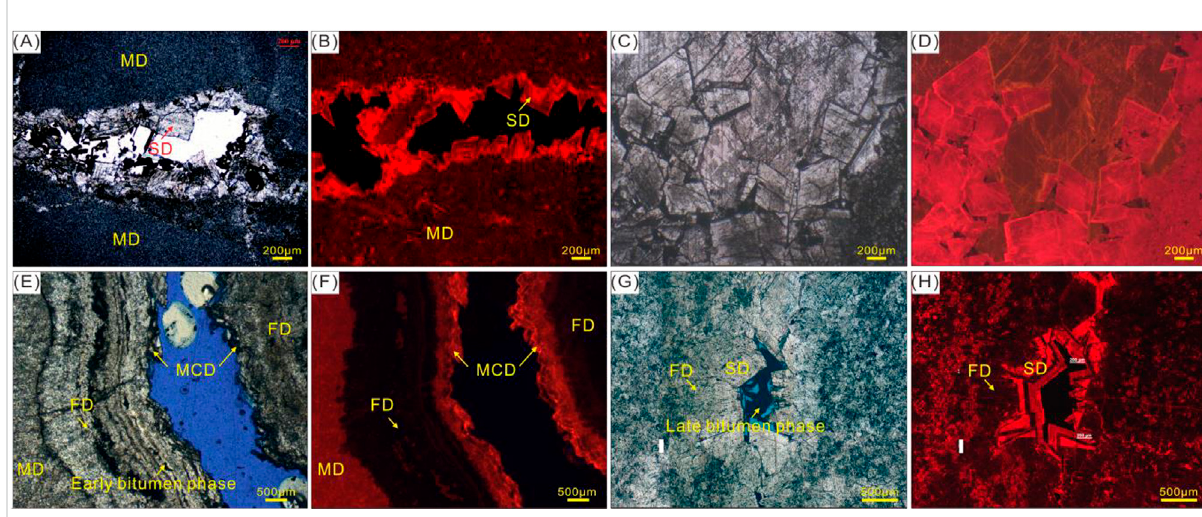
FIGURE 3 MicroscopiccharacteristicsfortheDengying FormationfromdrillingcoresinCentralSichuanBasin. (A) SDalongvuginterwallwithinMDunder PPL,WellGS1,4thMember,4970 m(Guetal.,2019). (B) SDexhibitsbright redandbanded structurewhereasMDexhibitdullredunderCL,WellGS1, 4th Member, 4972 m. (C) FMD with cloudy core and clear rim, Well GS16, 4th Member, 5450.15 m. (D) FMD exhibits bright red under CL, Well